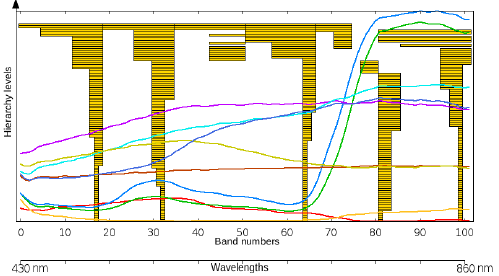
Figure 8: Pavia data set: selected bands at the different levels of the hierarchy using the proposed hierarchy aware algorithm for a hierarchy of merged bands obtained using spectra piece-wise approximation error band merging criteria